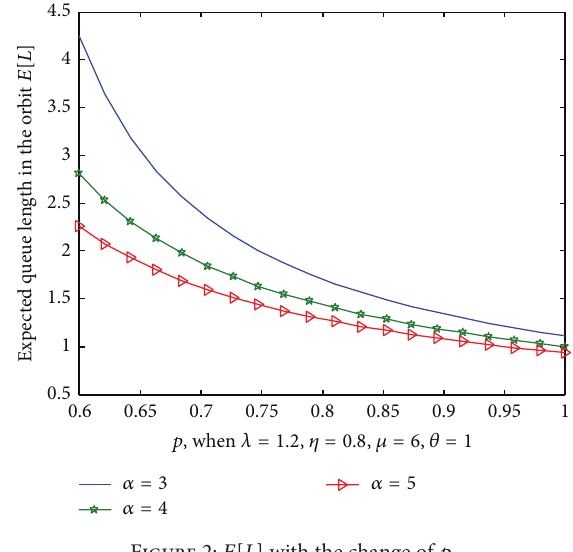
Figure 1: 𝑃 𝑏 and 𝑃 𝑓 with the change of 𝑝 . Figure 2: 𝐸[𝐿] with the change of 𝑝 .